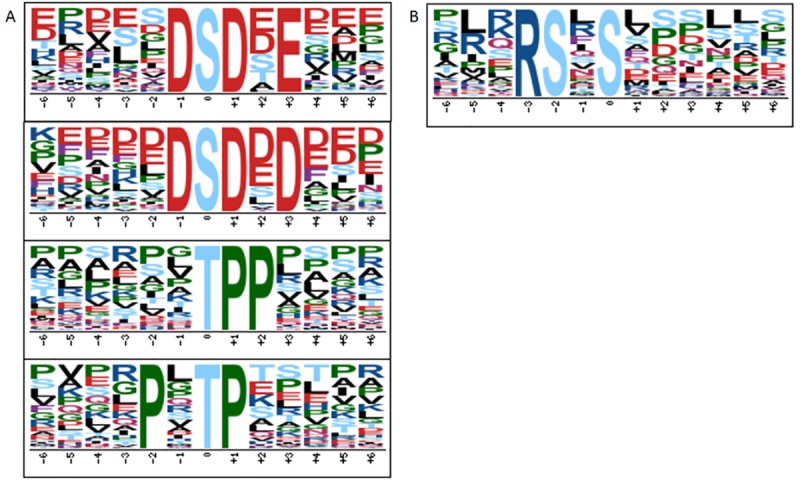
Phosphorylation-specific motifs using the Motif-X algorithm.(A) Pro-directed motif centered on Thr and Ser with a strong preference for additional Pro residues C-terminal to the phosphate. (B) Double-phosphorylation motifs found in our study.